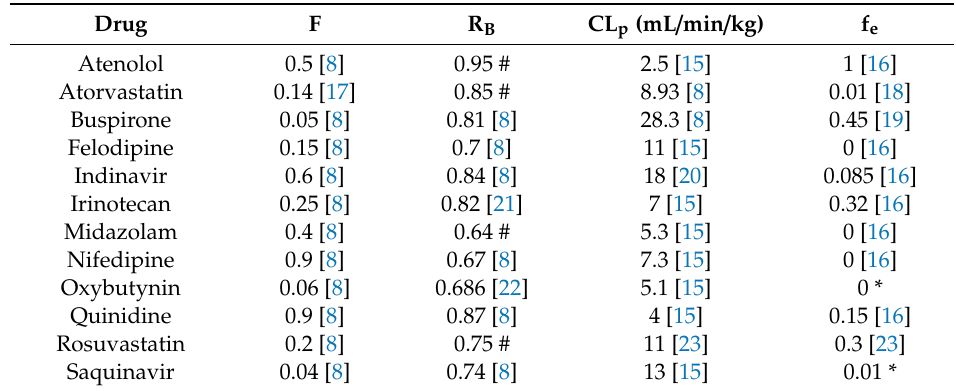
Table 2. Clinical pharmacokinetic data of the selected drugs for the calculation of F a × F g . Data sources are indicated. Due to a lack of literature data or conflicting data in the literature, R B values for several compounds are measured in-house (#).